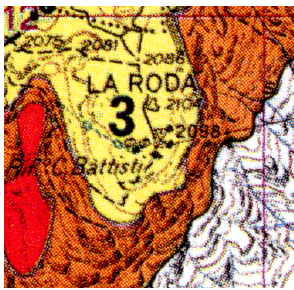
Figure 3. Original 1954 image.